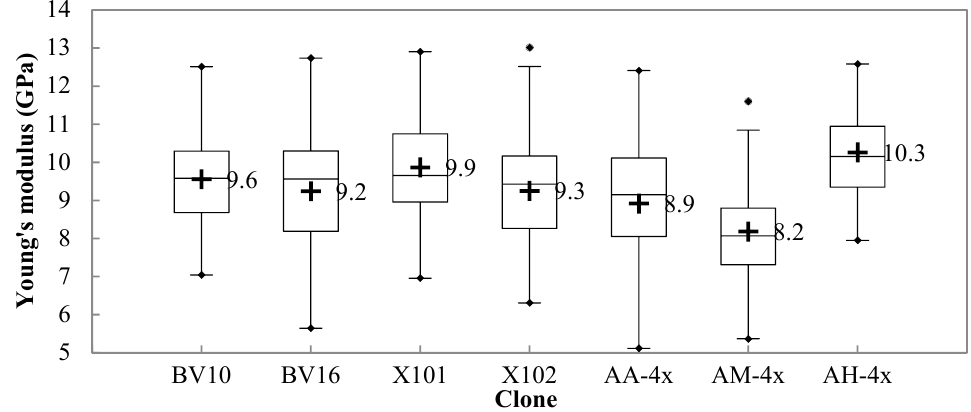
Figure 12. Variation of Young’s modulus in compression parallel to the grain (GPa).